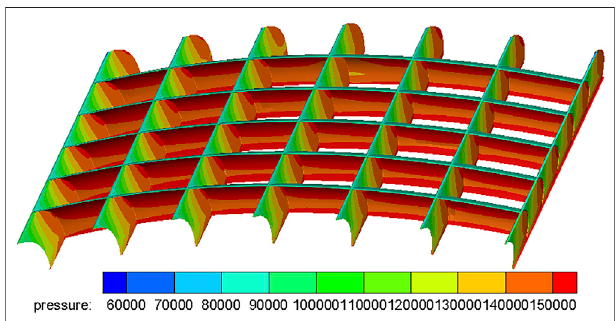
FIGURE 13 | The pressure distribution of the cascade.